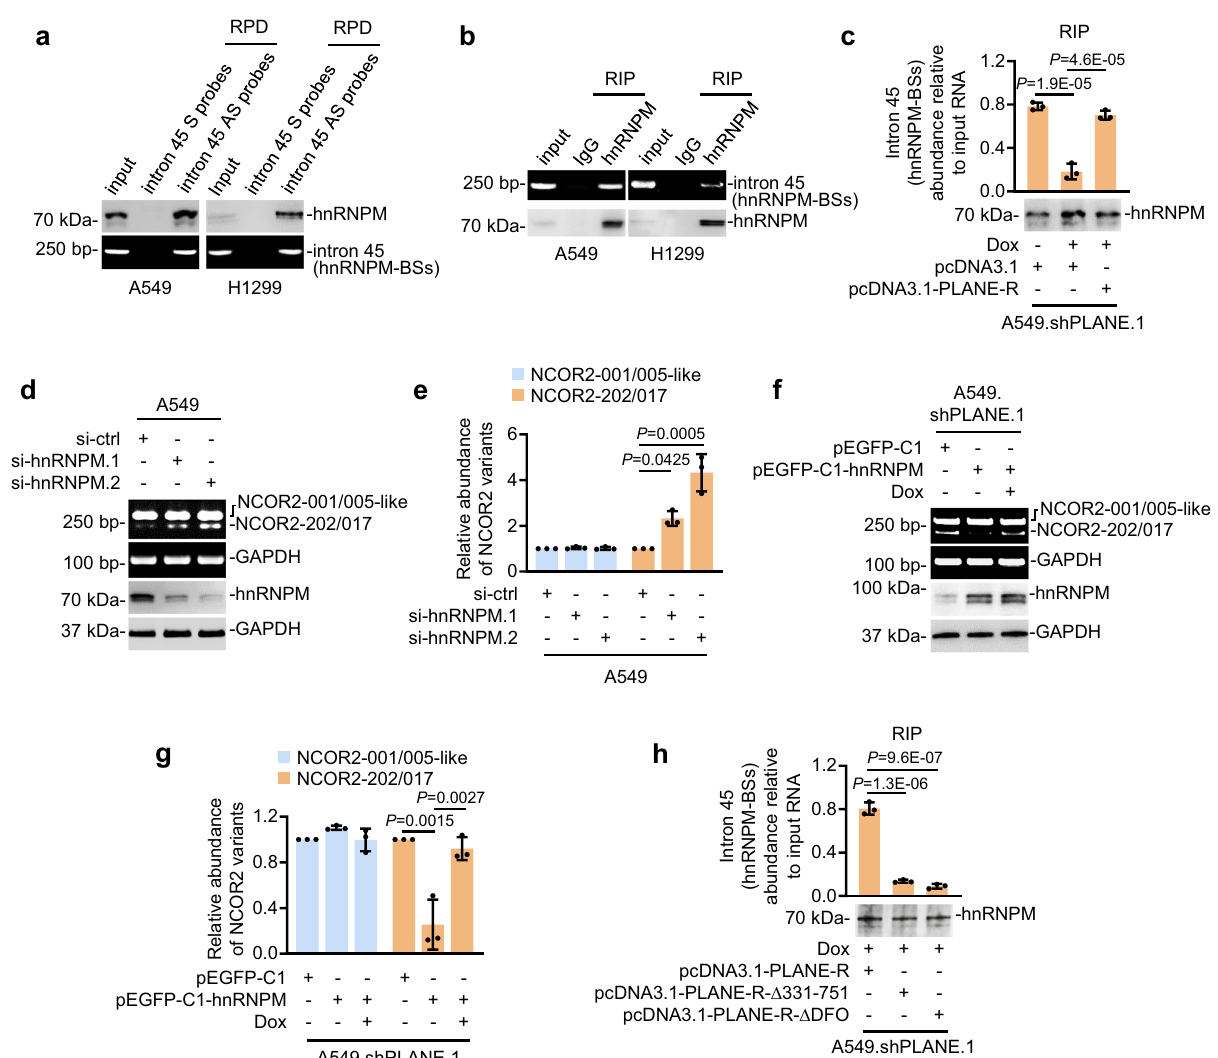
Fig. 6 PLANE links hnRNPM to regulation of NCOR2 pre-mRNA AS. a hnRNPM was co-pulled down with the NCOR2 pre-mRNA using antisense